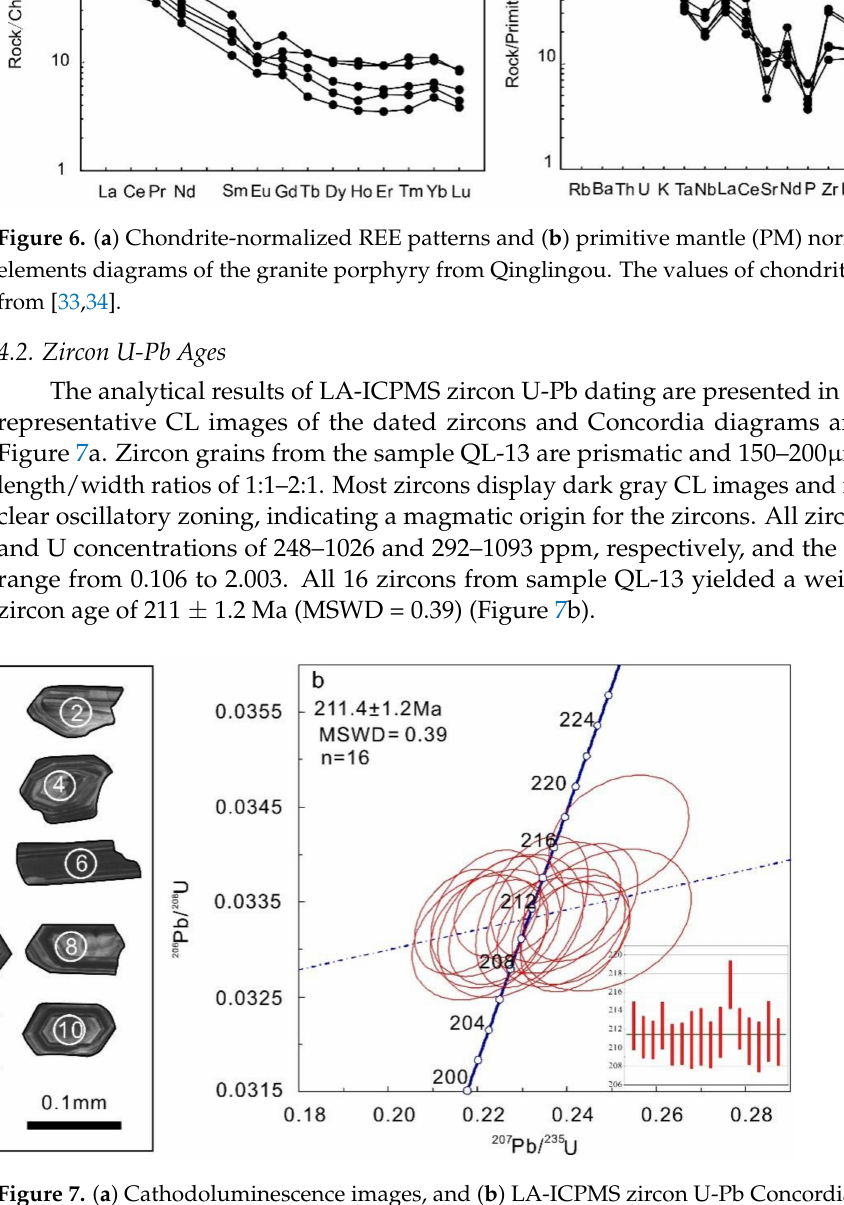
Figure 7. ( a ) Cathodoluminescence images, and ( b ) LA-ICPMS zircon U-Pb Concordia diagrams of ore-related granite porphyry from the Qinglingou